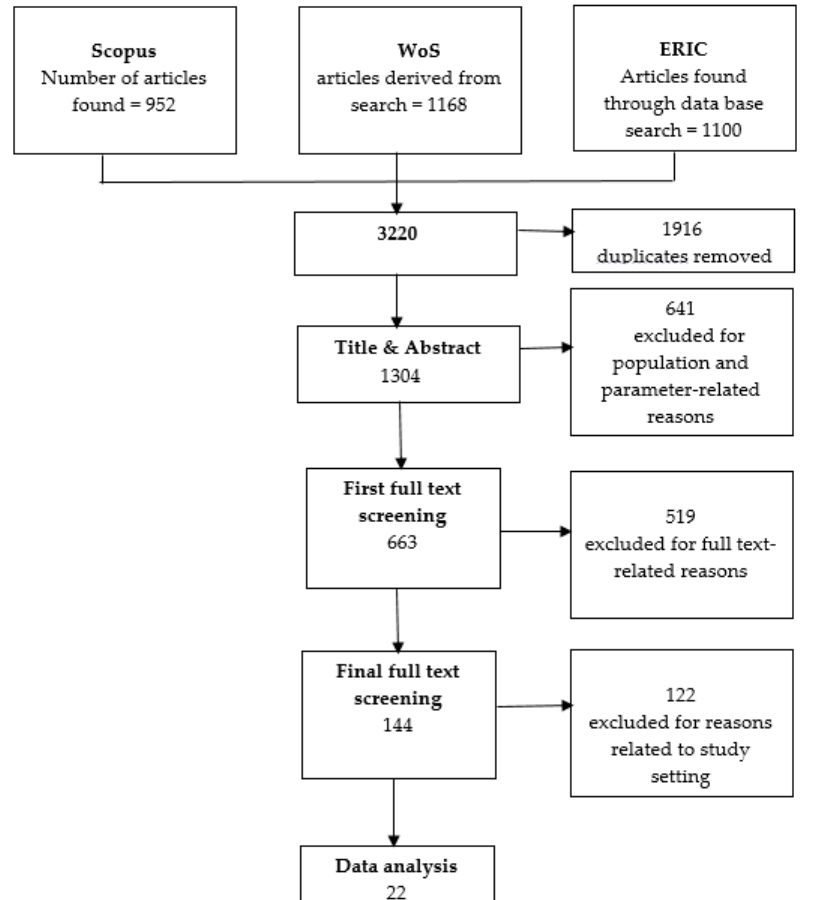
Figure 3. Article selection flowchart.